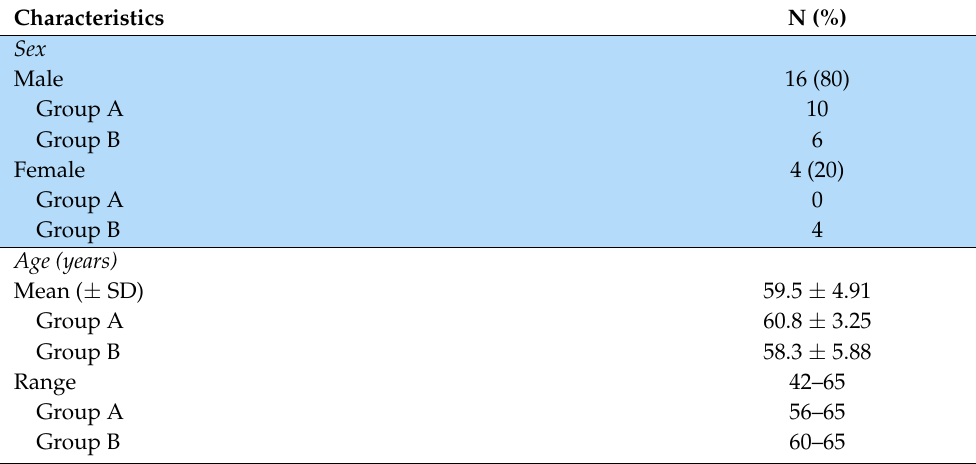
Table 1. Patients’